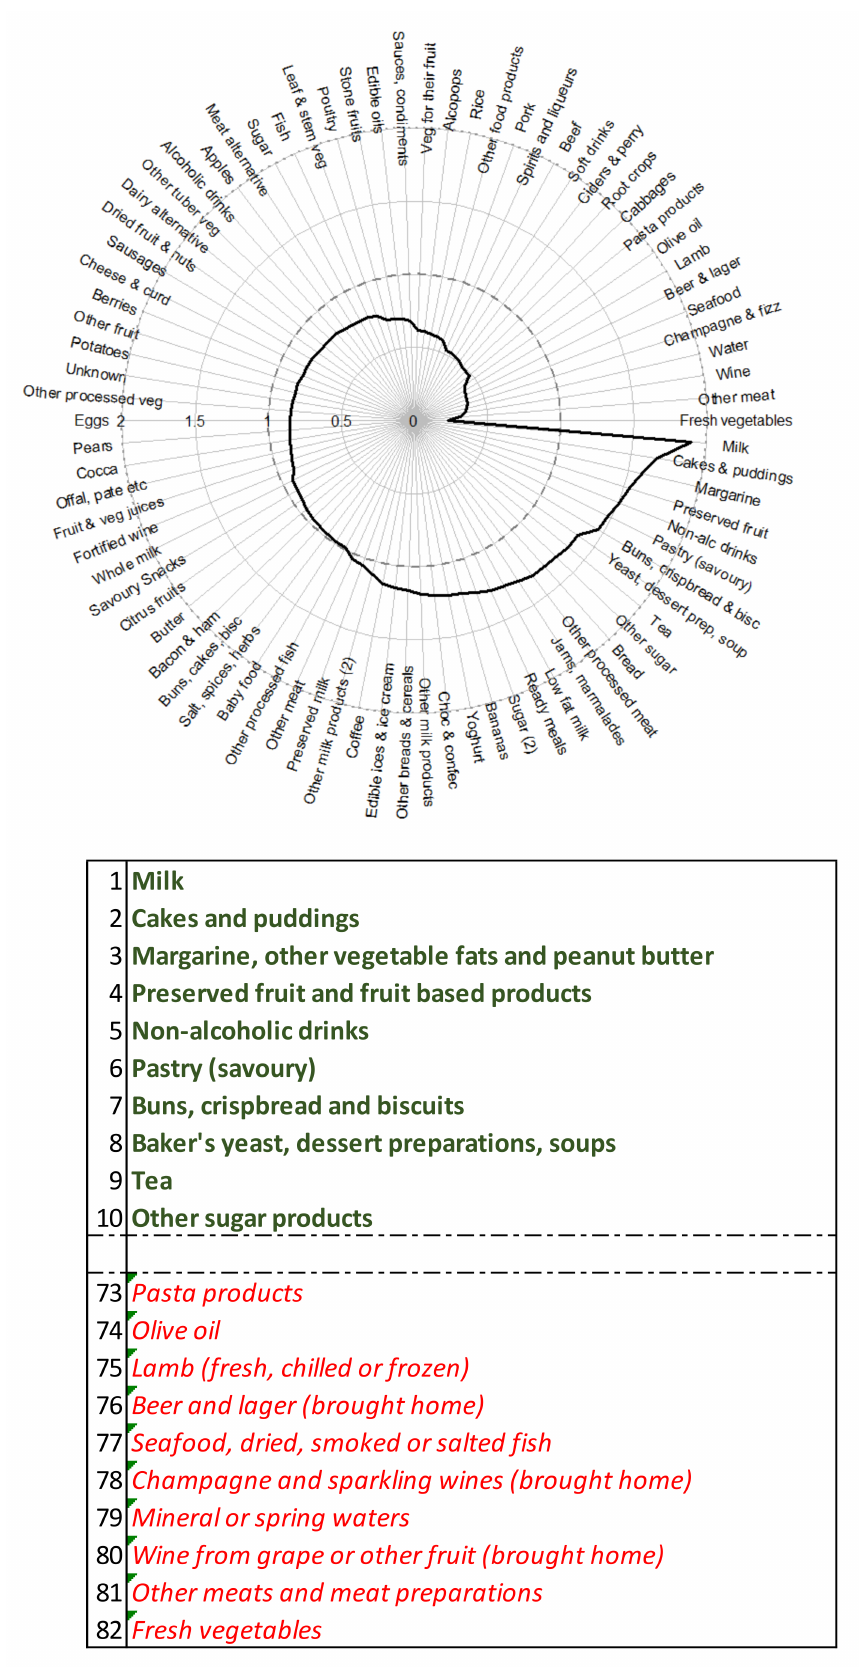
Figure A5. Afternoon tea ( n =